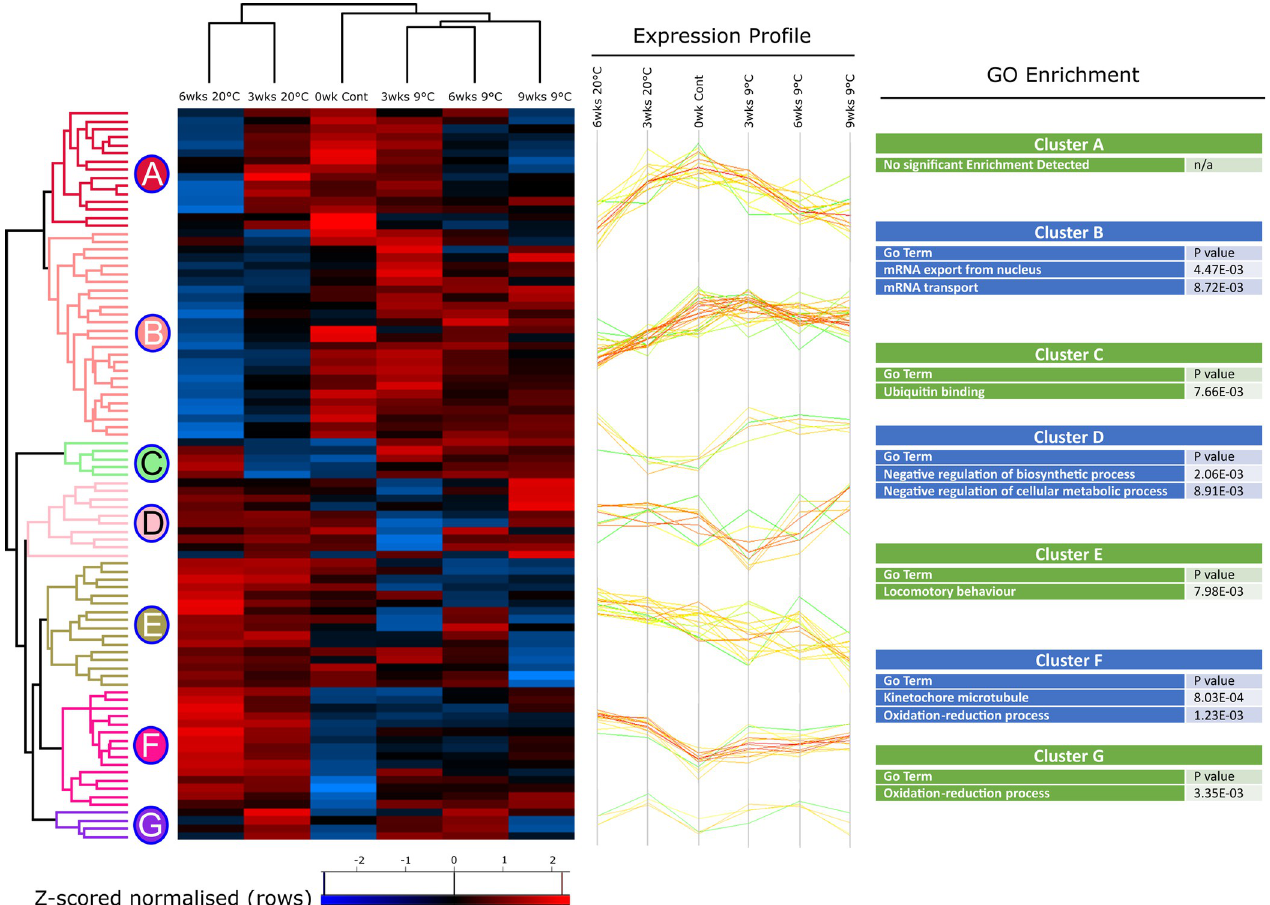
Fig 3. Heat map of H . megidis statistically significant proteins. Two-way unsupervised hierarchical clustering of the median Z-score normalised label-free quantification (LFQ) intensity values of all statistically significant proteins (n = 91) for freshly emerged IJs, IJs stored at 9˚C for 3, d 9 weeks or IJs stored at 20˚C for 3 and 6 weeks. Hierarchical clustering resolved 5 distinct clusters. Differences in protein abundance are indicated by colour changes from low (blue) to high (red) protein abundance representative of changes in Z-score normalised log 2 -fold transformed LFQ intensity values. Selected GO terms enriched in each cluster are displayed (right), along with the P value for that category. https://doi.org/10.1371/journal.pone.0266164.g003 Various heat shock proteins (HSPs) were detected in S . carpocapsae (S1 Table) and generally increased in abundance over time, and to a greater extent at 9˚C. HSPs are molecular chaper- ones which aid folding of proteins, prevent stress induced aggregation or misfolding of